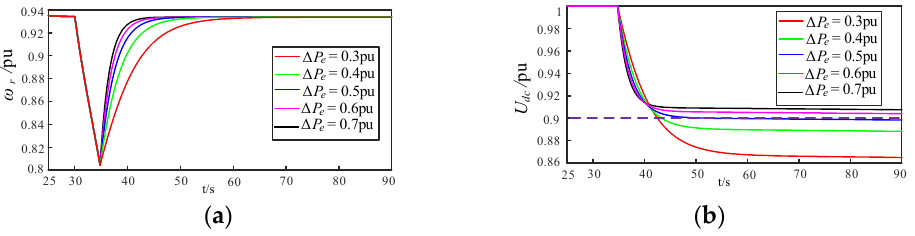
P Δ . ( a ) rotor speed response; ( b ) DC voltage of VSC-HVDC re- Figure 6. Response of different Figure 6. Response of different ∆ P e . ( a ) rotor speed response; ( b ) DC voltage of VSC-HVDC response. e sponse.